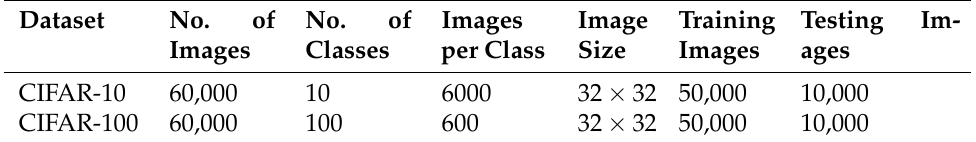
Table 3. Summary of the dataset properties.